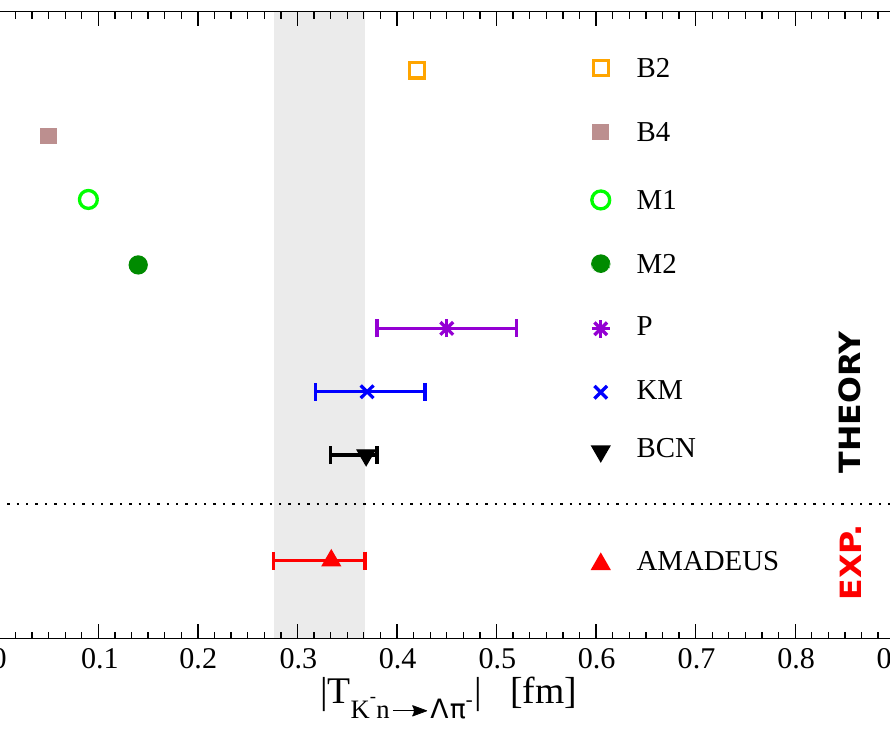
Figure 2. (Color online) Modulus of the non-resonant transition amplitude for the K − n obtained by AMADEUS in Ref. [20], compared with theoretical predictions: Barcelona (BCN) [6], Kyoto-Munich (KM) [7], Prague (P) [8], Murcia (M1 and M2) [9], Bonn (B2 and B4)